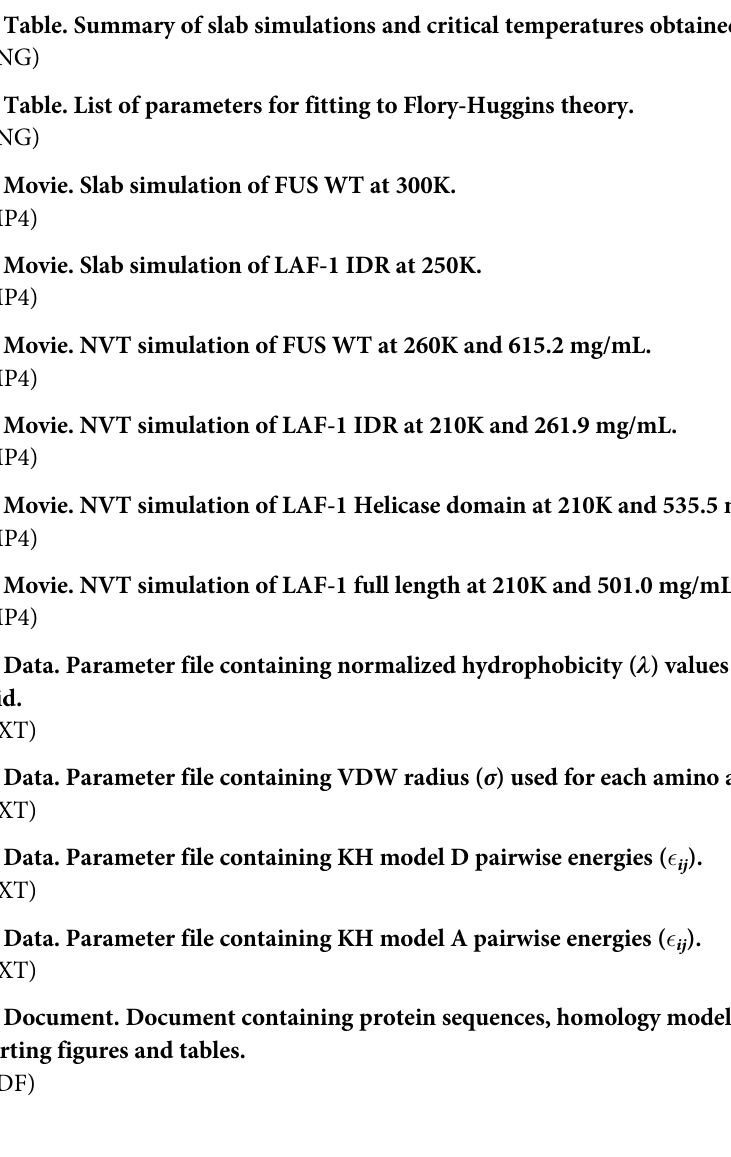
S4 Table. Interaction parameters ( (cid:15) ) used for KH-A model. ij S5 Table. Summary of slab simulations and critical temperatures obtained. S6 Table. List of parameters for fitting to Flory-Huggins